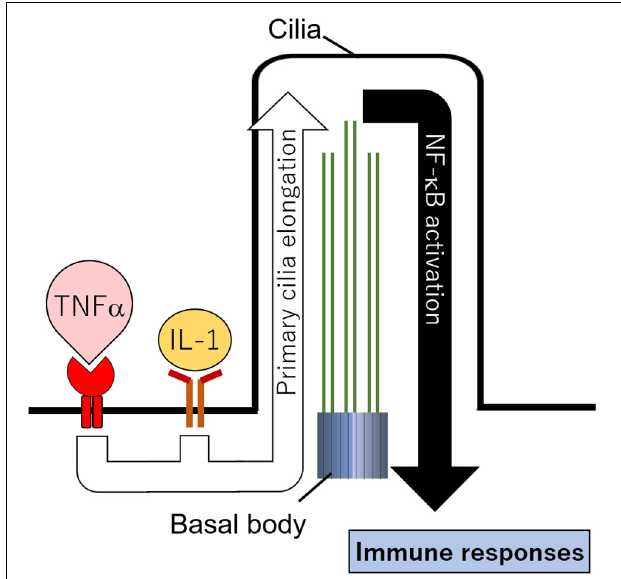
FIGURE 4 | Hypothetical cilia regulation by immune signals. Cytokines including IL-1 and TNF α elongate primary cilia length. NF κ B localized in primary cilia is activated and promotes immune